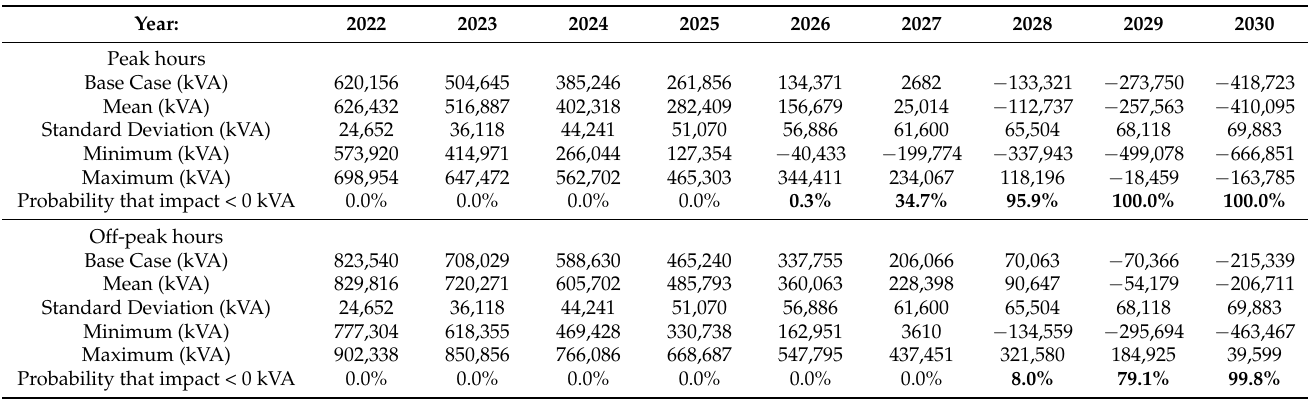
Table 8. Monte Carlo simulation, showing impacts during peak and off-peak hours (2022–2030) and the probability of negative impacts.